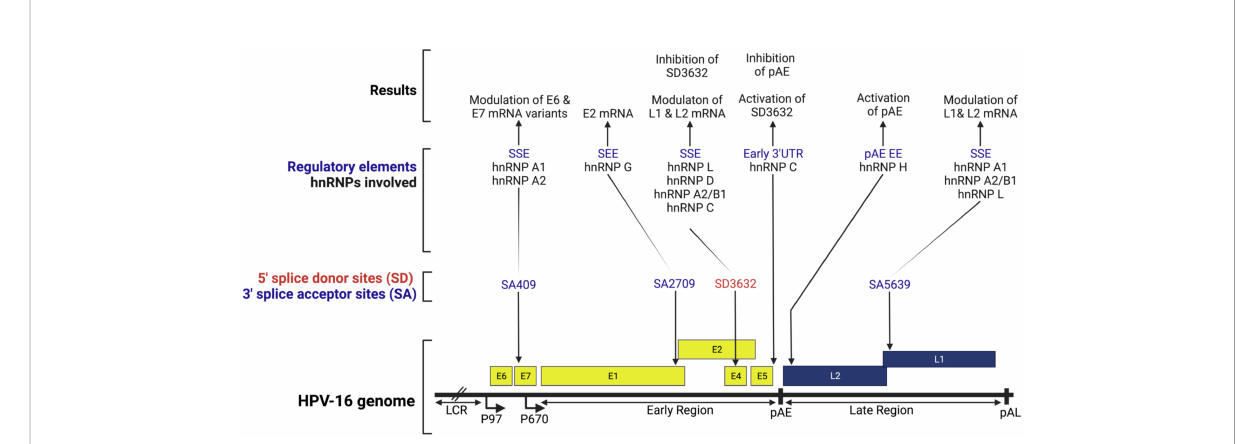
FIGURE 4 Schematic representation of the HPV-16 genome. This fi gure shows splice sites and the interfering and interacting positions of hnRNP proteins in the HPV-16 splicing sites. LCR, long control region; p97, early promoter; p670, late promoter; Early genes (E1, E2, and E4-7); late genes (L1 & L2); pAE, early polyadenylation signal; pAL, late polyadenylation signal; SSE, splicing silencer element; SEE, splicing enhancer element; EE, enhancer element. The image was created with